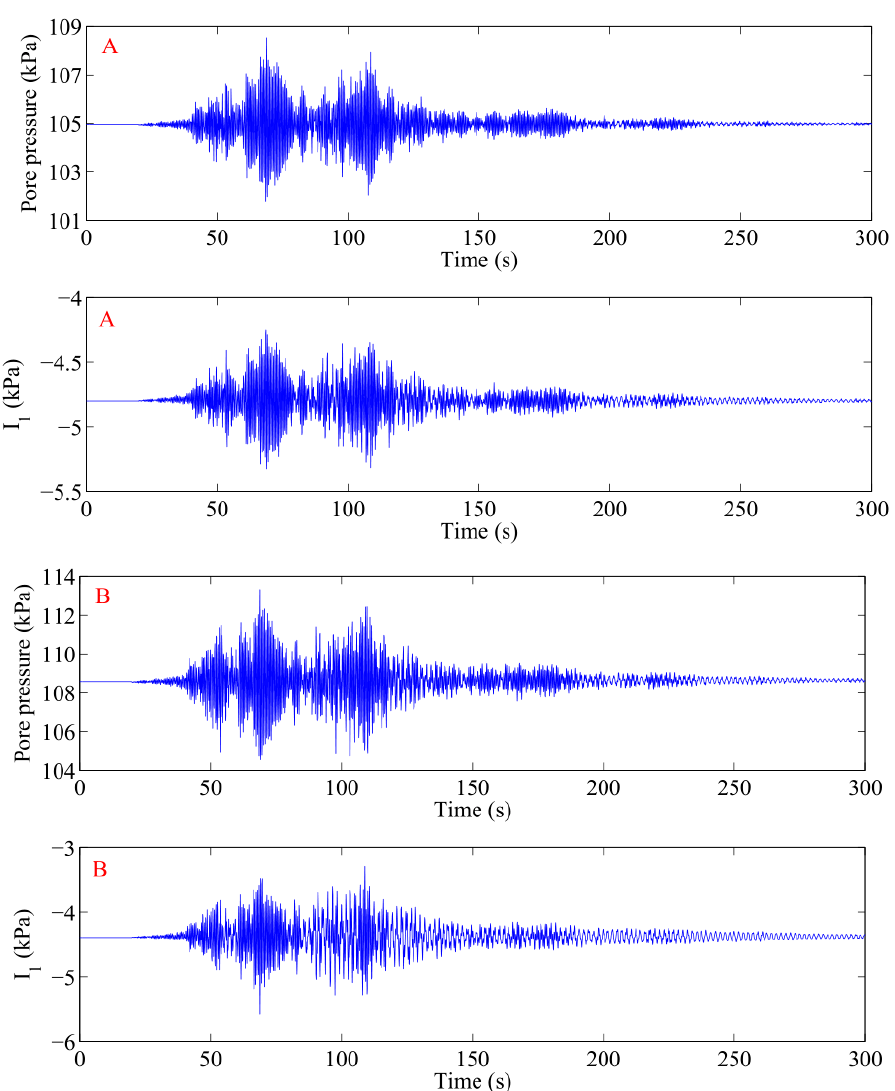
Figure 8. Time history of pore pressure and e ff ective stress I 1 at the two typical position A and B in the seabed foundation labelled in Figure 2. There is no residual pore pressure built up in dense seabed